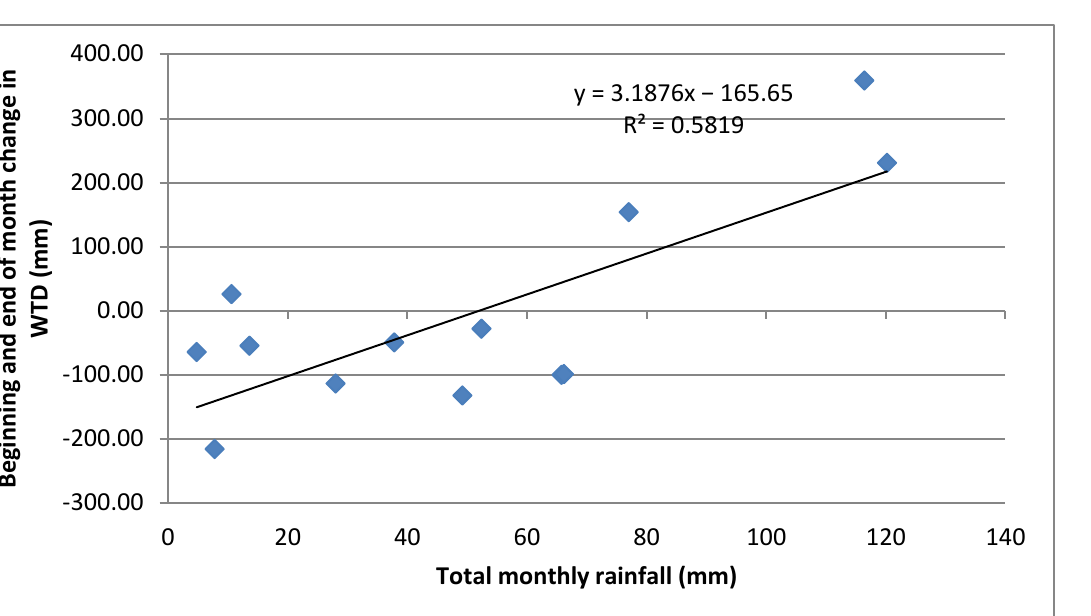
Figure 4. Relationship between monthly WTD change and total rainfall for BH3.